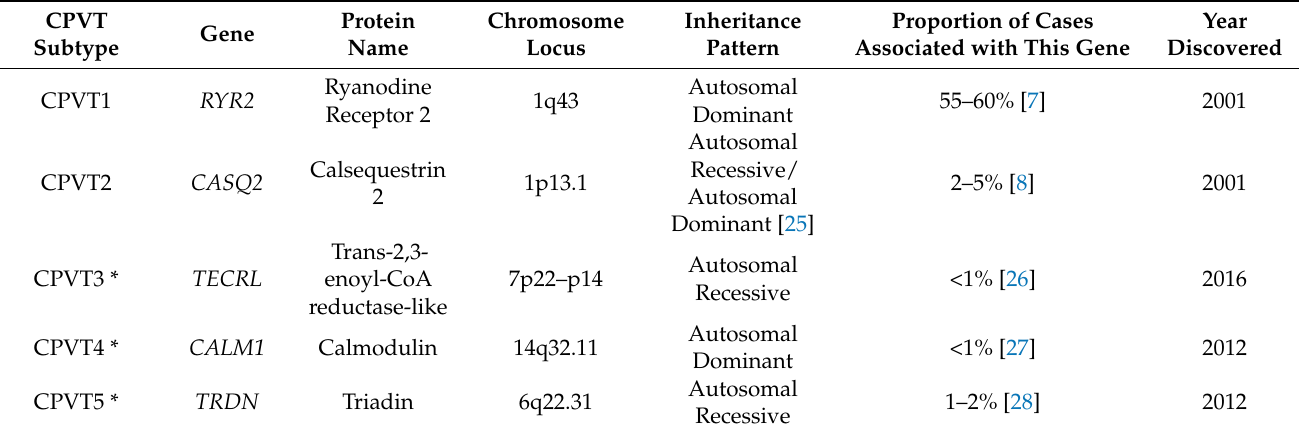
Table 1. Genetic subtypes of